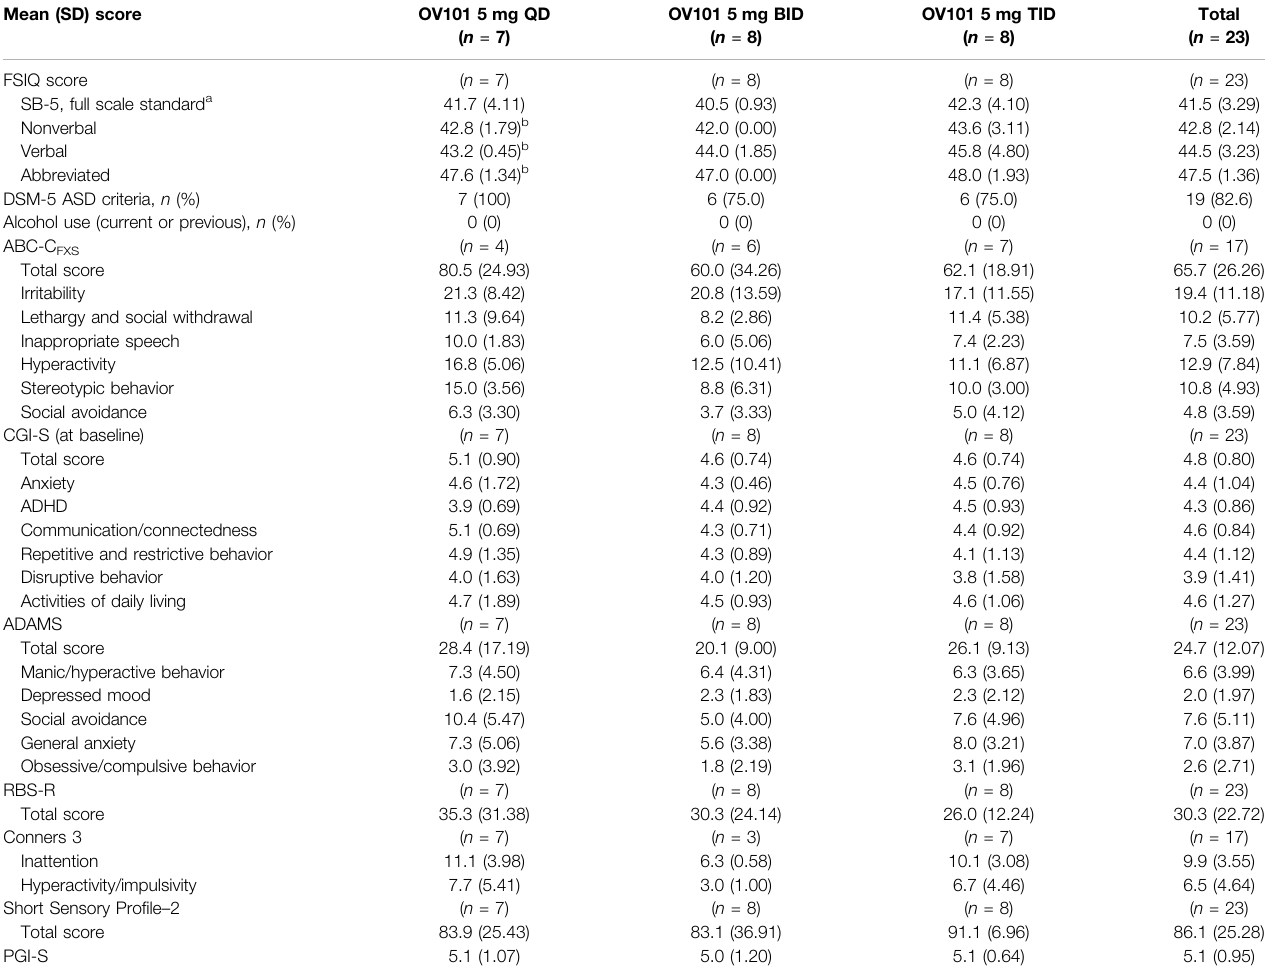
TABLE 2 | Baseline clinical characteristics. Mean (SD)